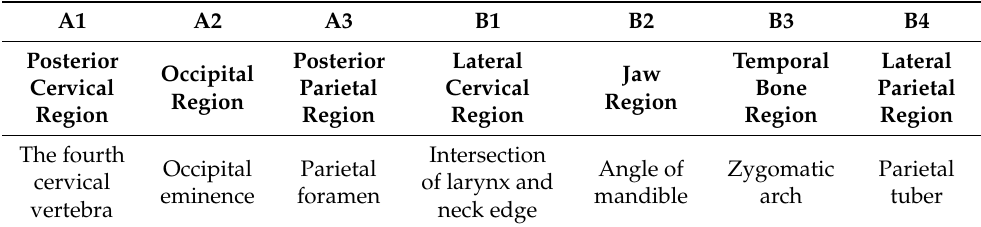
Table 6. The partition node corresponding to each